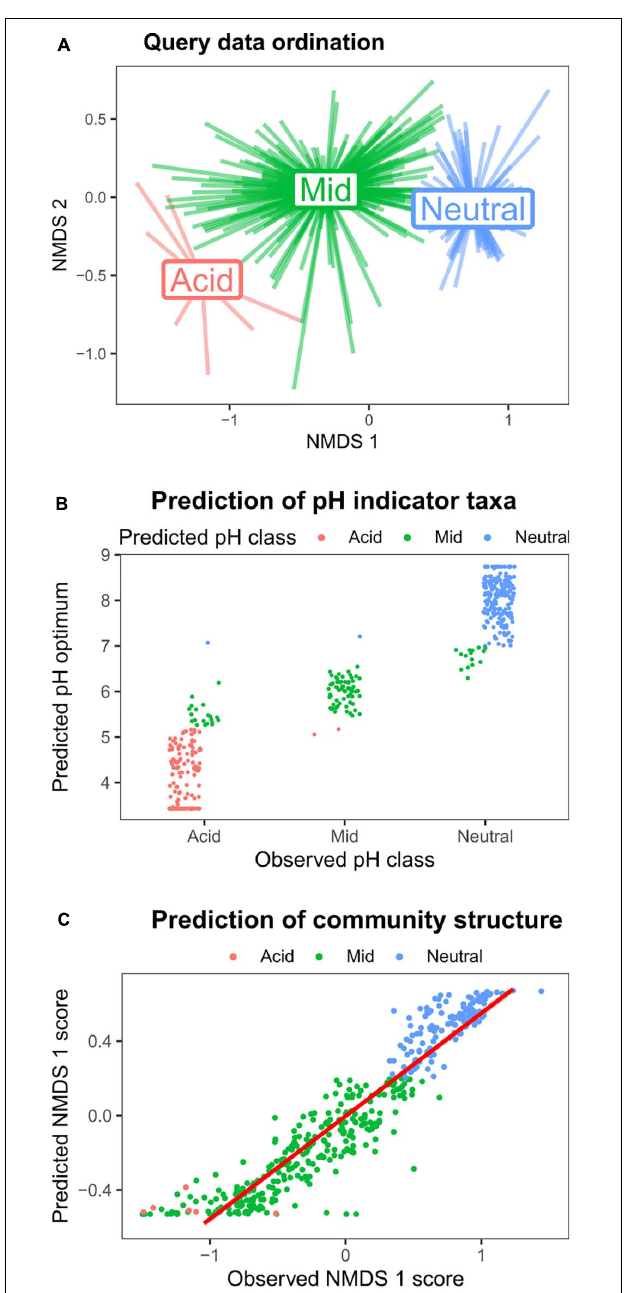
FIGURE 5 | Validating the pH models using a query dataset. Taxa strongly responsive to soil pH were identified from Query dataset 1 ( Table 1 ), and then matched to the CS database to evaluate utility of the approach. (A) NMDS ordination plot of the query dataset, with pH groupings denoted by color (red = pH < 5.2; green = pH > 5.2 < 7; and blue = pH > 7). (B) Indicator species analyses on the query dataset revealed 477 OTUs strongly associated with the three pH classes (“Observed pH class”). The y -axis values and point color denote the predicted pH optimum, and predicted pH class following matching to CS database. (C) The relative abundances of the 100 most abundant taxa in the query dataset were predicted using the CS HOF models of matched taxa, and subjected to NMDS ordination. The plot shows that the predicted abundances of these taxa reliably predicted the observed data first axis NMDS